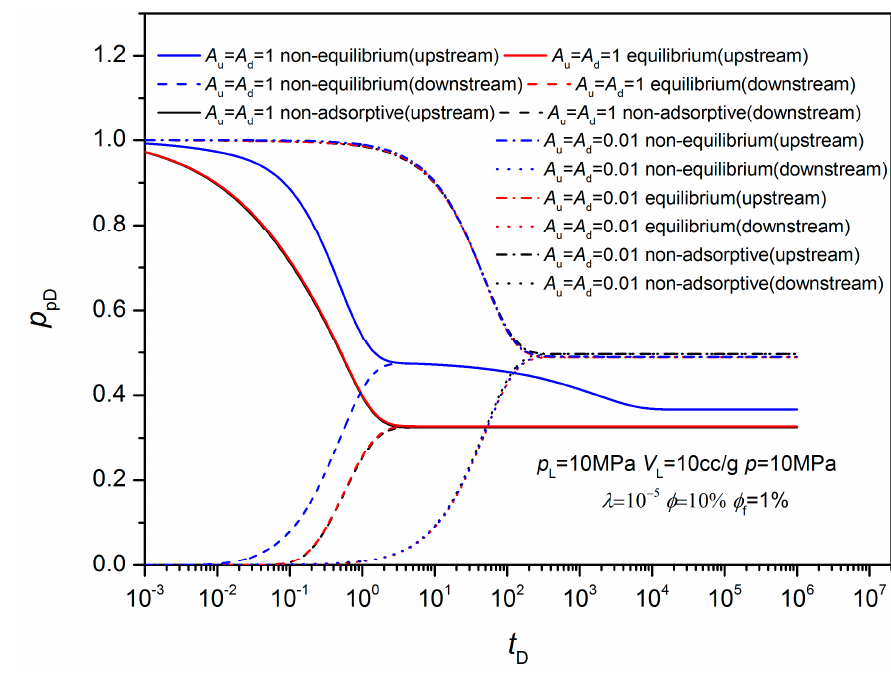
Figure 9. The influence of the Langmuir pressure on the pseudo-pressure curves of the non-equilibrium sorption model.